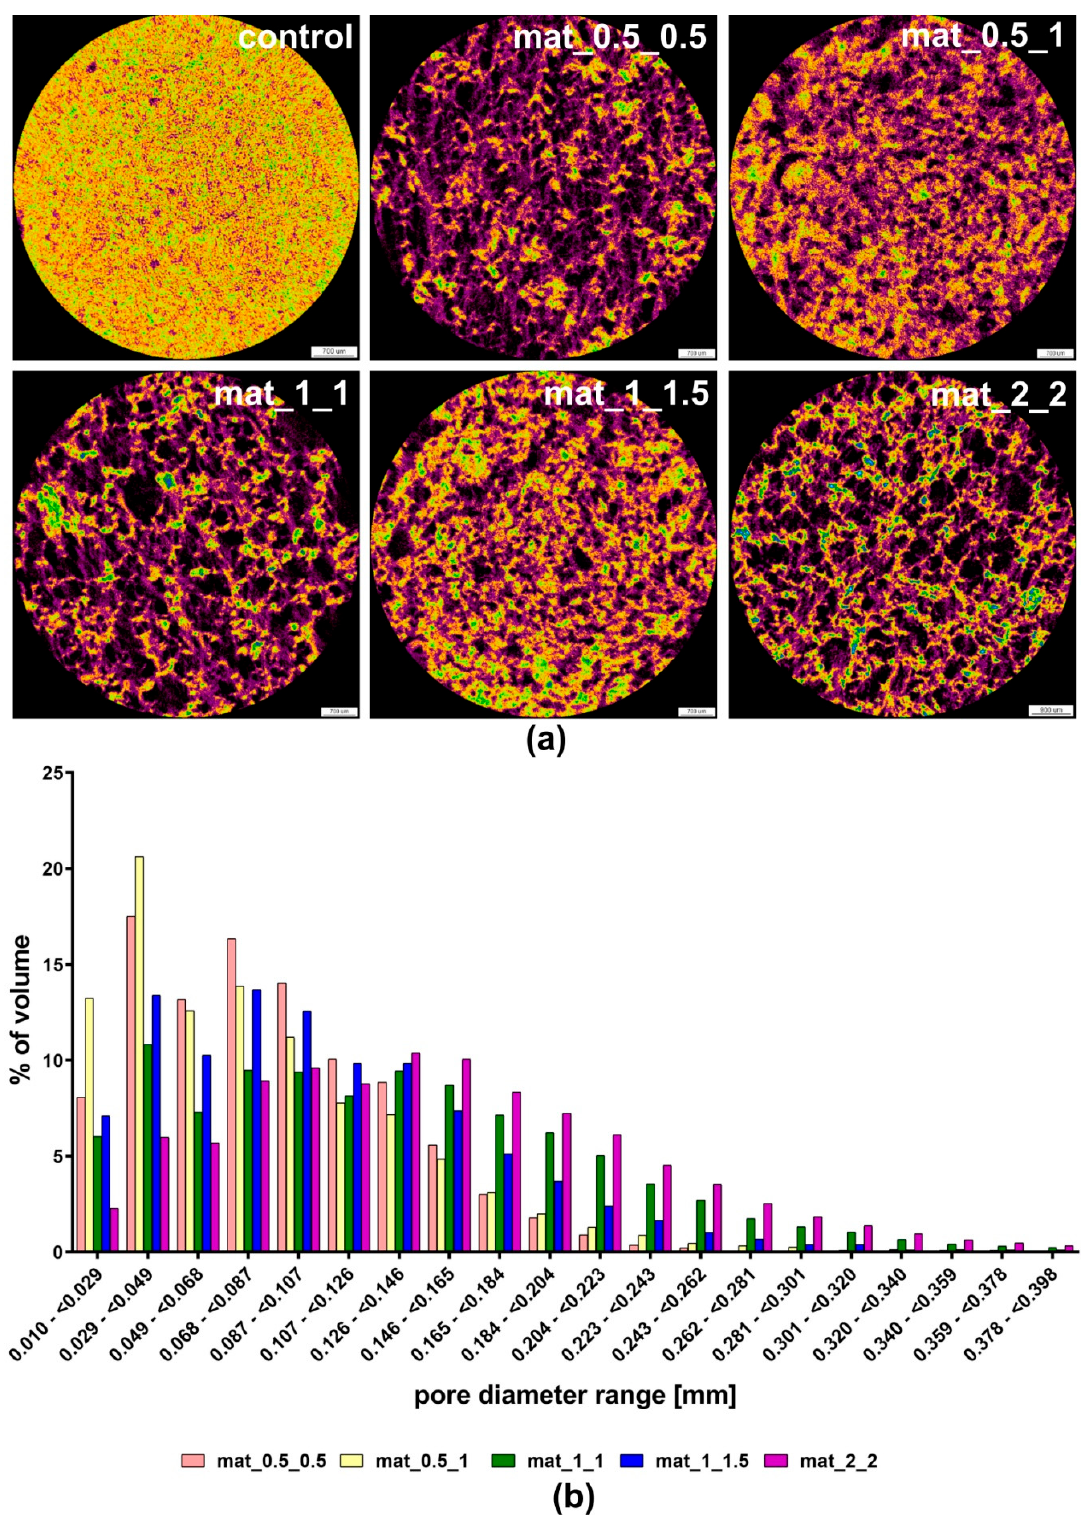
Figure 2. Pores size and their distribution within the structure of biomaterials determined with the use of micro-CT: ( a ) cross-section images of the scaffolds (black color—pores; violet color—polysaccharide matrix, yellow/orange/green/blue colors—nanoHA); ( b ) chart presenting pore share of different diameters in the structure of the scaffolds.